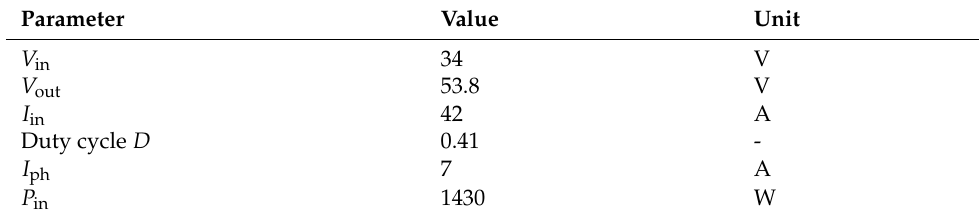
Figure 14. Inductor current waveform for I in = 42 A. Table 6. Bench test operating condition.